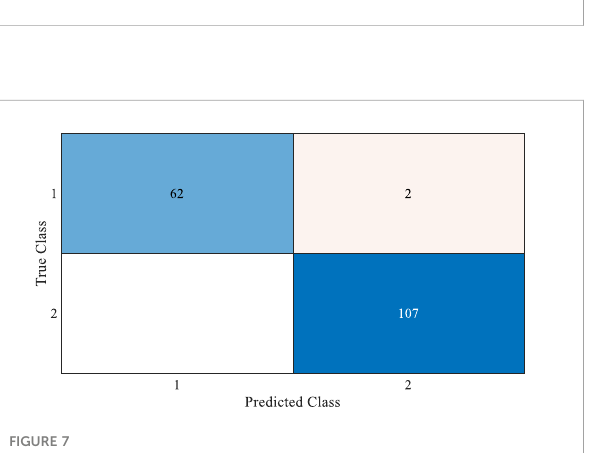
FIGURE 6 Confusion matrix for the best achieved results by the FLN algorithm using the WBCD.